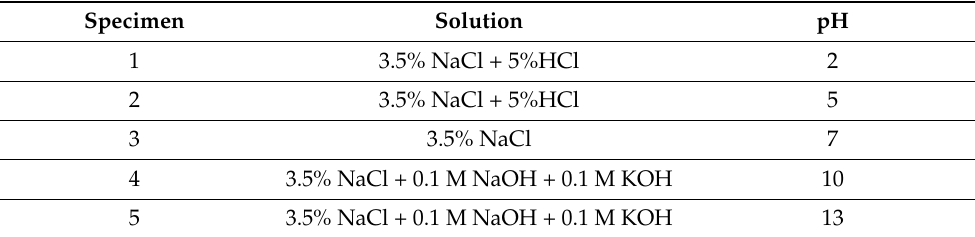
Table 3. Different pH solutions used as